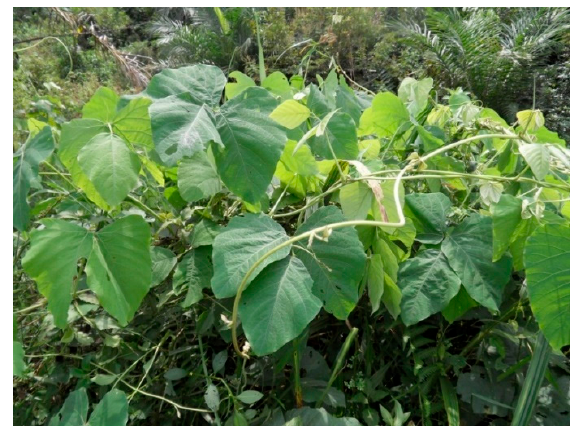
Figure 15. Mucuna pruriens .